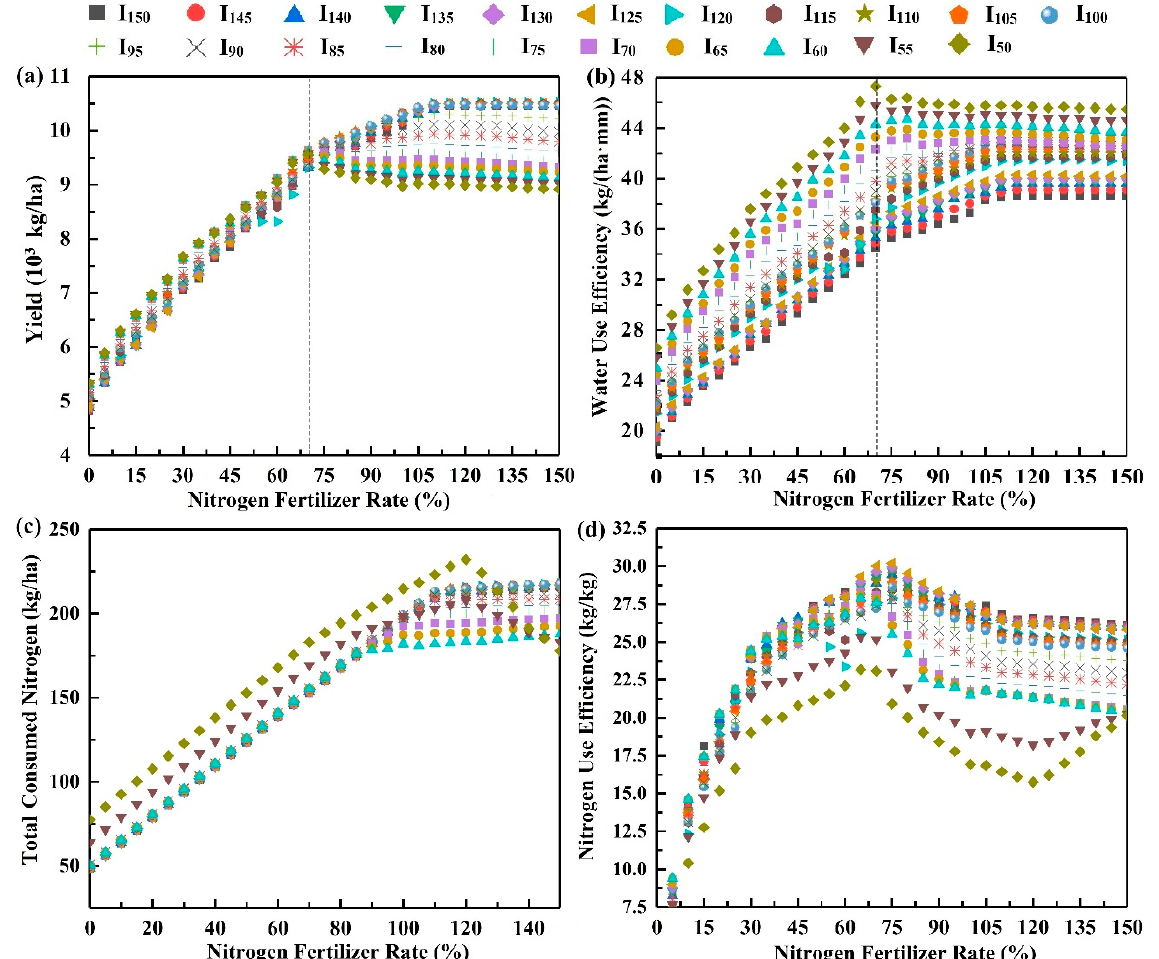
Figure 5. Simulated yield ( a ), WUE ( b ), TCN ( c ) and NUE ( d ) under different simulated SDF scenar-